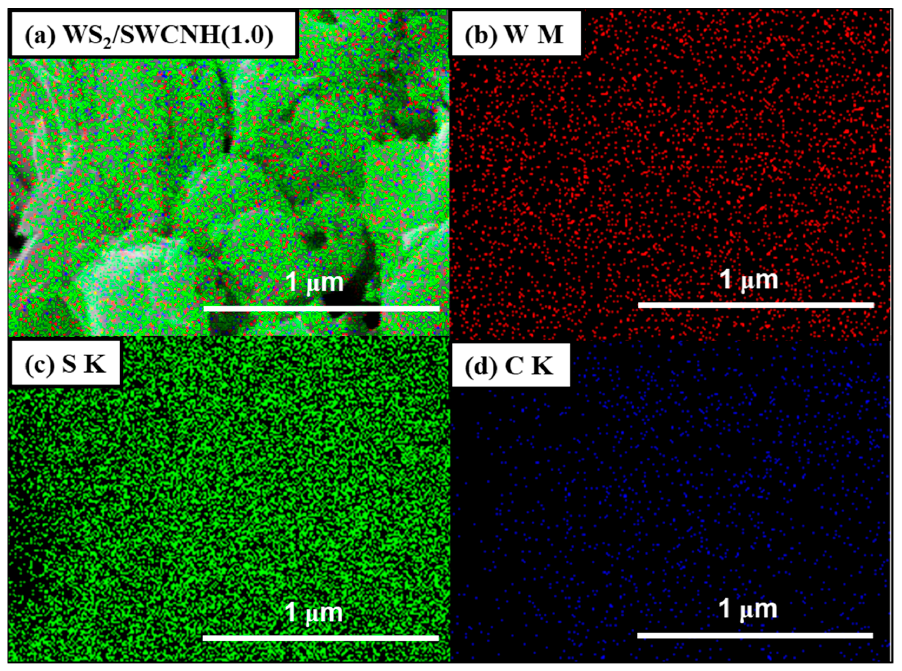
Figure 4. FE-SEM-EDX mapping of the sintered WS 2 /SWCNH(1.0) nanocomposite: ( a ) WS 2 /SWCNH(1.0), ( b ) W M, ( c ) S K, and ( d ) C K.